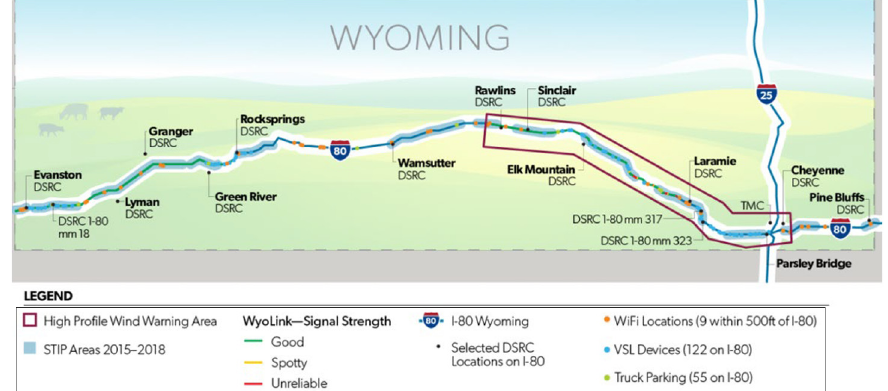
Figure 2 WYDOT Pilot deployment map (USDOT,